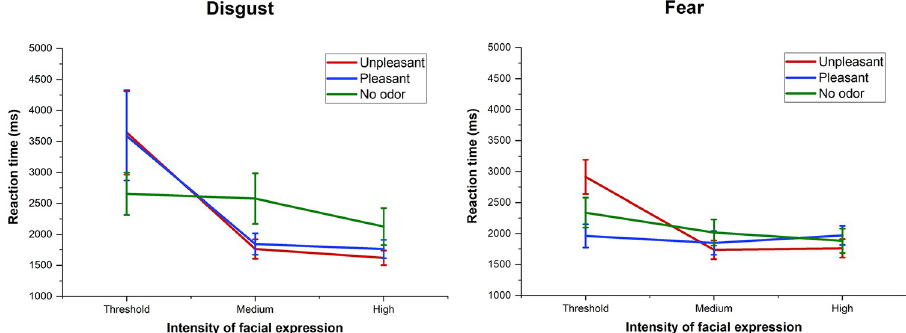
Fig 5. Analysis of RT between intensities for disgust and fear. Graphs showing RT means and standard errors for disgust and fear at threshold, medium and high expression intensities in different odor conditions.